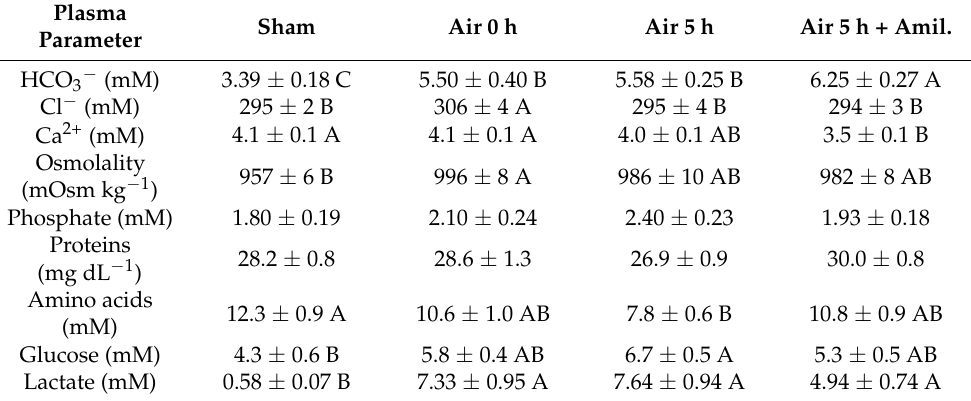
Table 3. Plasma parameters in S. canicula exposed to air and in vivo recovered in 100 µ M amiloride for 5 h. The experiment includes undisturbed-control fish (Sham), a group sampled immediately after 18 min air exposure (Air 0 h), and 5 h after recovery in control water (Air 5 h) or containing 100 µ M amiloride (Air 5 h + Amil.). Data are expressed as mean ± s.e.m. Different letters indicate significantly different groups ( p < 0.05, one-way ANOVA followed by a Tukey’s post hoc test, n =